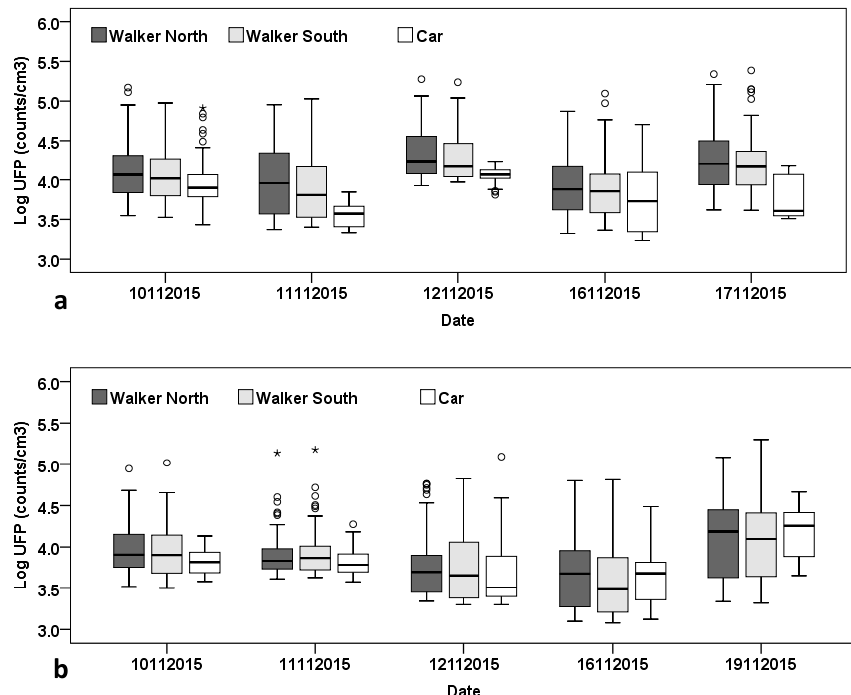
Figure 2. Box plots of the log-transformed UFP concentrations for each commute in the field campaign by commuter; ( a ) Morning commutes; ( b ) Afternoon commutes.